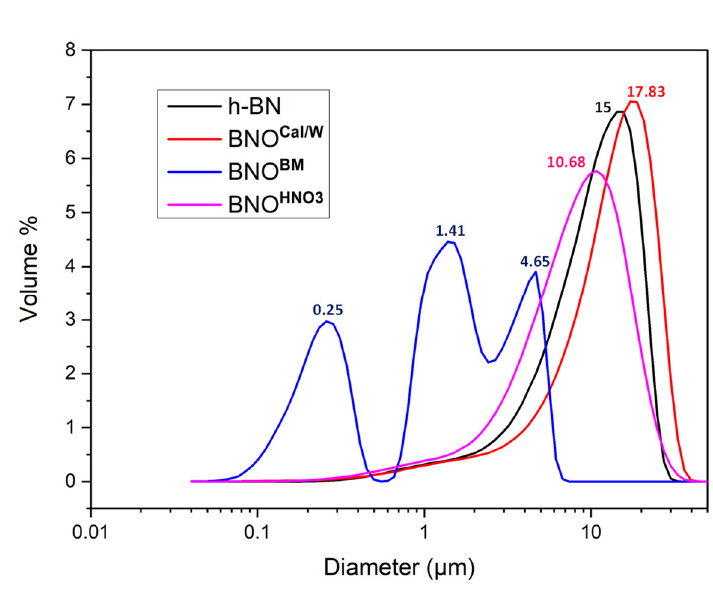
Figure 9. h-BN and hydroxylated BNO granulometry in water (volume %)